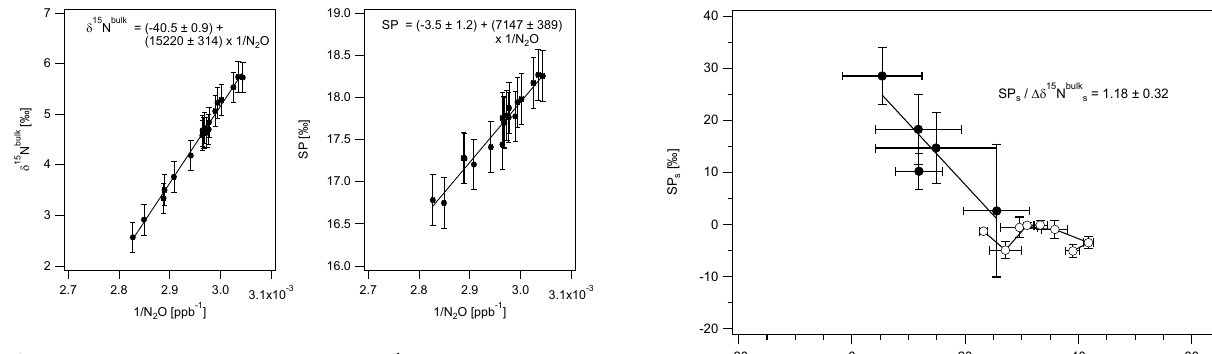
Fig. 5. Exemplary 24h Keeling plot (23 September noon– 24 September 2010 noon) after fertiliser addition. Site preference and δ 15 N bulk are plotted versus the inverse of the N 2 O concentra- tion. The intercept of the ordinary least square linear regression cor- responds to the isotopic signature of the main N 2 O emitting process ( δ 15 N bulk s , SP s ) and is given together with its 1 σ uncertainty.